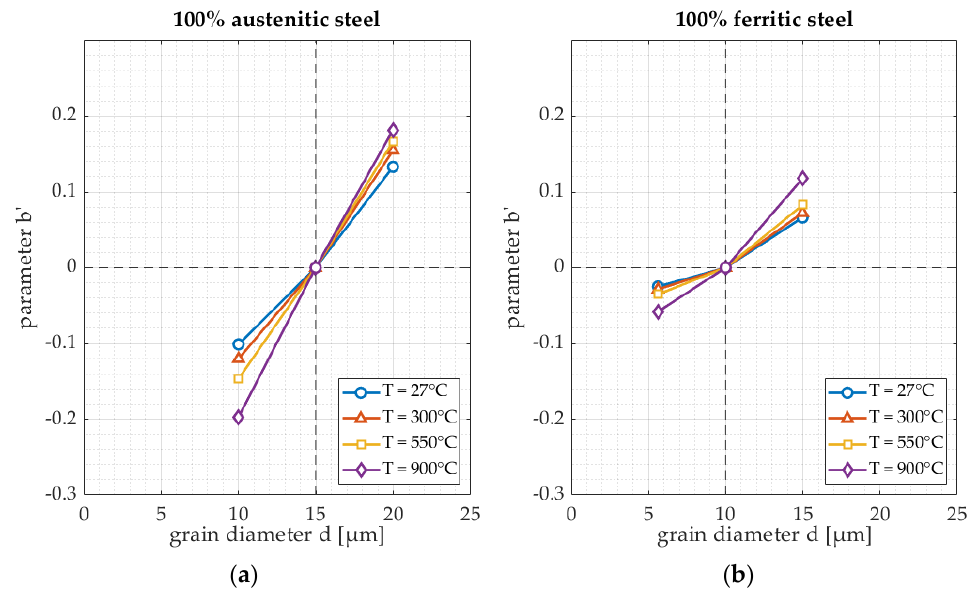
Figure 14. The relation between the grain diameter 𝑑 , and parameter 𝑏′ for two material types and four temperatures: ( a ) shows 100% austenitic steel; and ( b ) 100% ferritic steel.